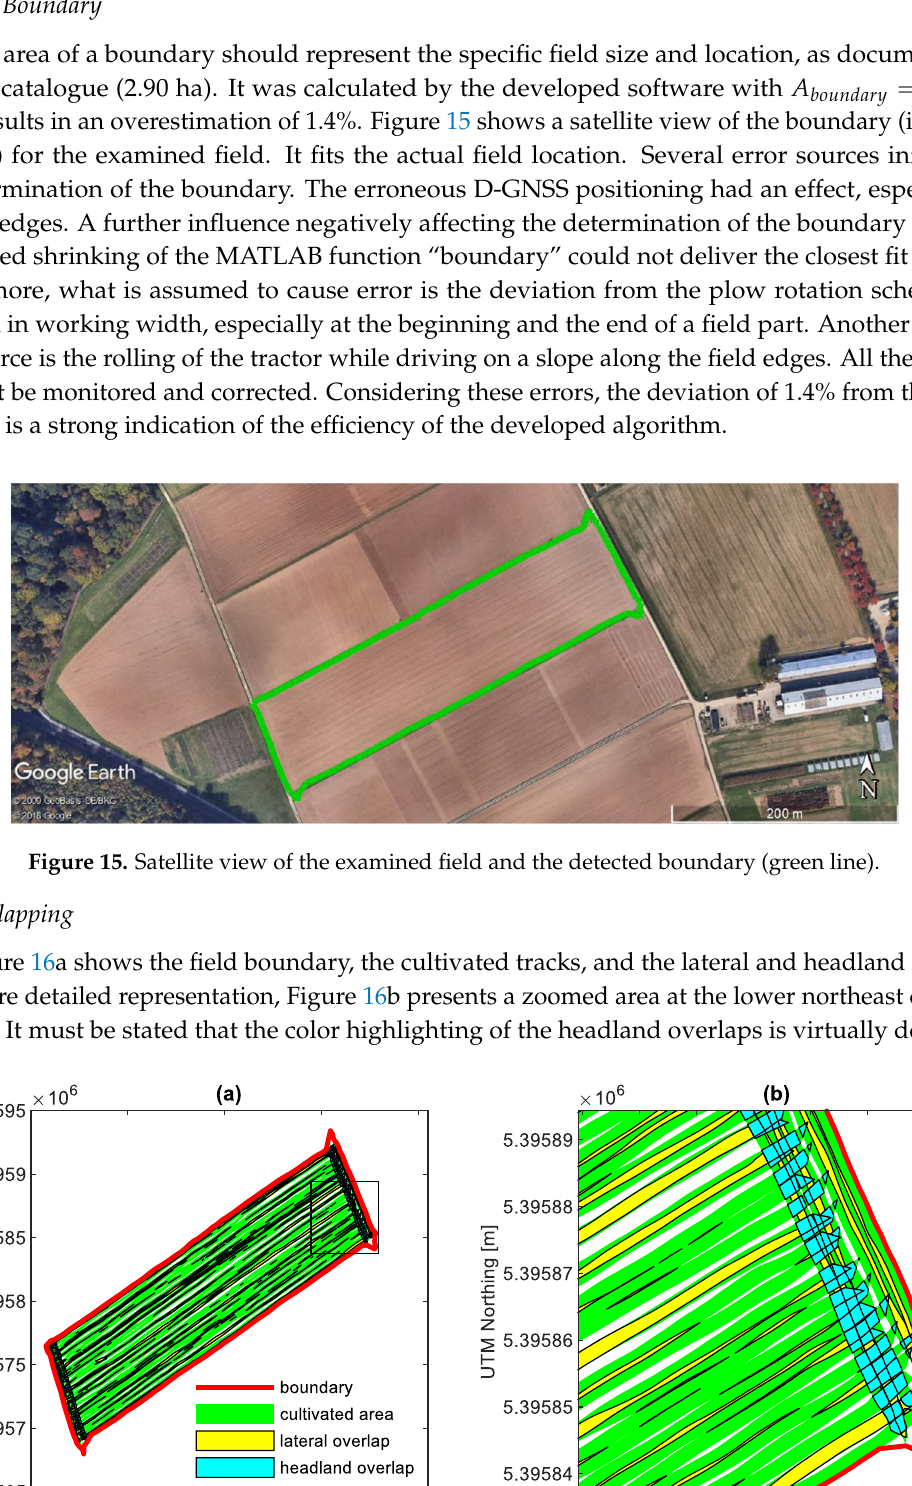
Figure 14. Zoom of the polygons formed from three exemplary cultivated tracks.